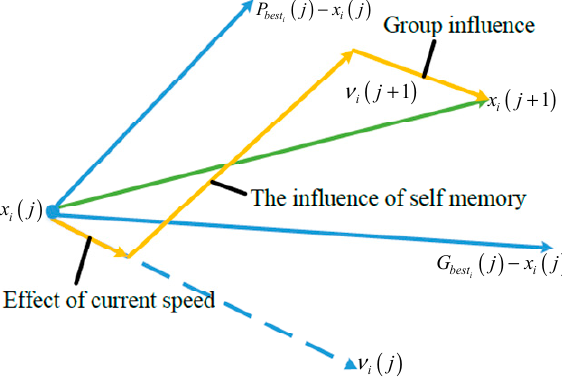
Figure 3. Search criteria in standard PSO algorithm.